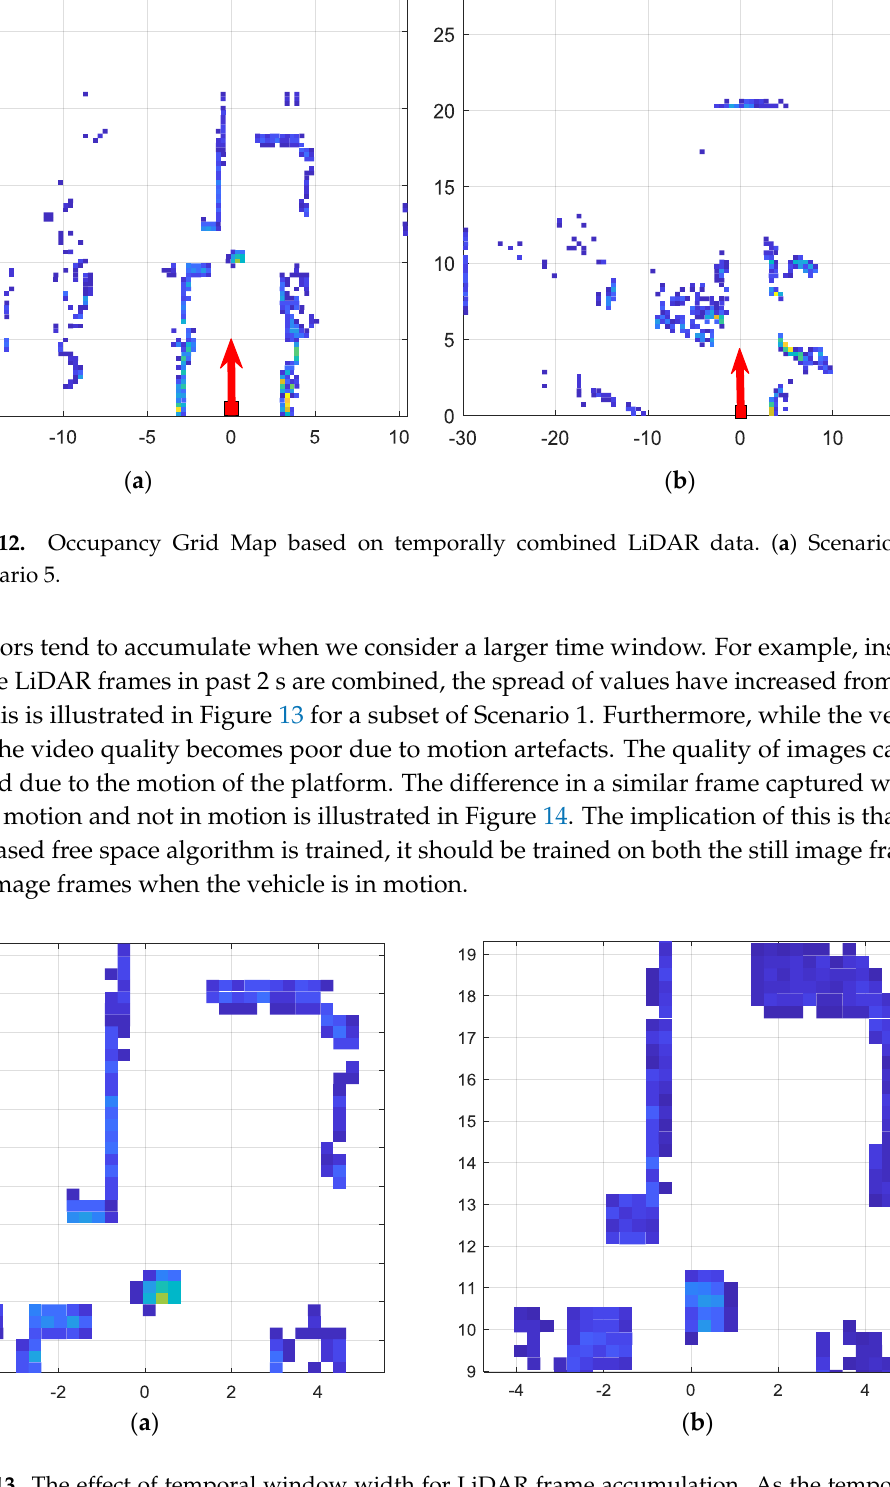
Figure 14. The effect of motion artefacts on video capture. ( a ) When the vehicle in motion; ( b ) When the vehicle is still. 4.4.2. Limitations and Directions of Future Work We identify several limitations of the proposed method for fusion and experimental setup. Firstly, the image-based FSD algorithm presented in this paper is utilized for demonstration of the benefits of fusion of LiDAR and camera data. It should be noted that, in terms of performance there are many advanced algorithms that are based on deep neural networks [39,40] or Gaussian Mixture Models [41]. The classifier used in this study is trained on a very small amount of data, as compared to state-of-the-art algorithms that are trained on thousands of hours of training data. However, image based free space detection and obstacle avoidance algorithms have well known failures such as when image pixels are saturated. The limitations of image based recognition algorithms are partly culpable for recent fatal accidents involving driverless vehicles [42,43]. Furthermore, the proposed data fusion method does not adequately address the issue of seeing through glass. Both types of the optical sensors used in this study, would not recognize see through